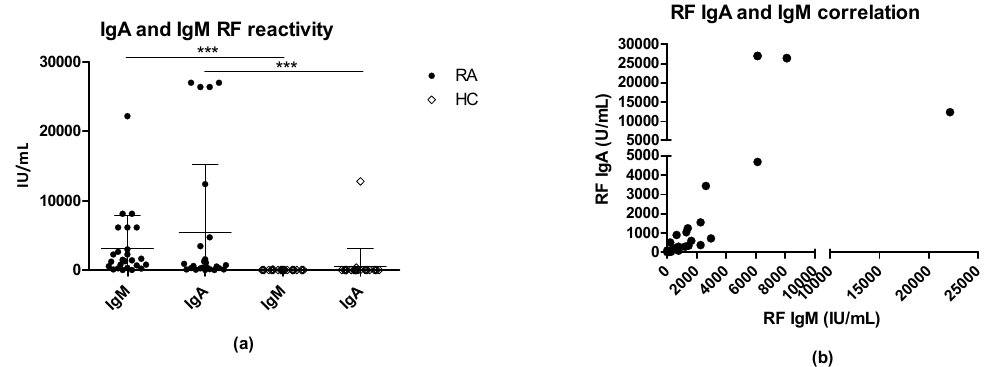
Figure 4. Determination of rheumatoid factor IgM and IgA in rheumatoid arthritis (RA) and healthy control (HC) samples by enzyme-linked immunosorbent assay: ( a ) RF IgA and IgM reactivity in RA and HC samples; ( b ) correlation between RF IgA and IgM. *** p < 0.001. A mean of 3237 IU/mL was found for IgM RFs for RA sera, which was significantly elevated compared to HC sera with an average of 64 IU/mL ( p < 0.0001). Moreover, a moderately positive correlation was determined between IgM and IgA RFs titers (r = 0.5979) ( p = 0.0016). No correlation was determined between EBNA1 IgG and IgA RF (r = 0.006223),